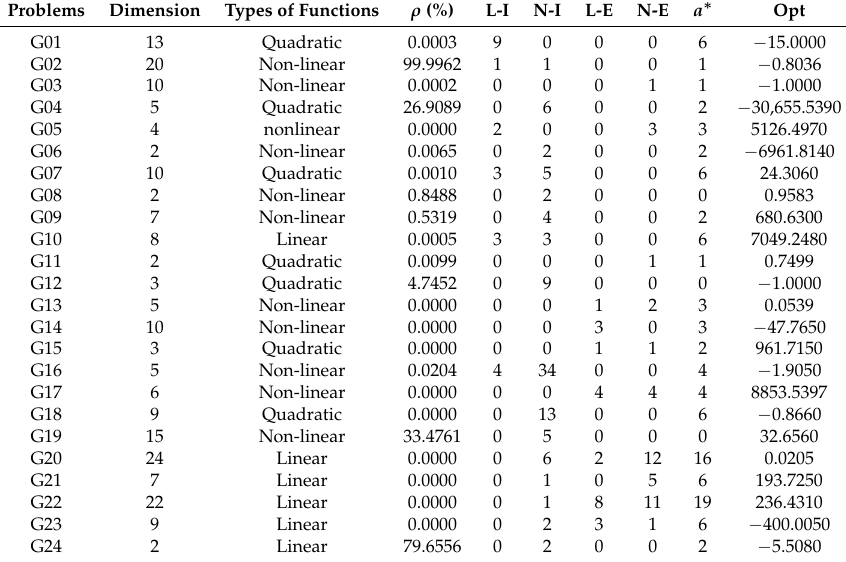
Table 1. Characteristic of 24 standard-functions.